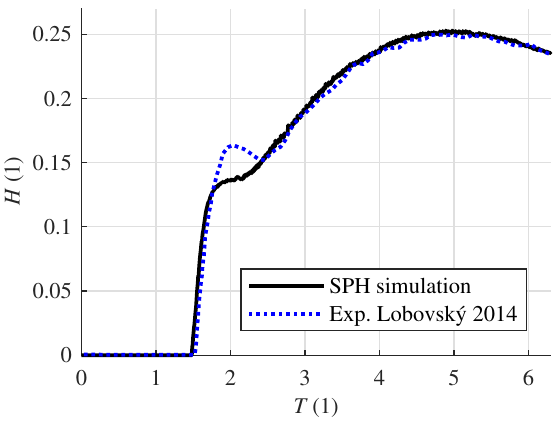
Fig. 8. Non-dimensional liquid surface height as a function of non-dimensional time at position H3. Exp. Lobovský 2014 [2].